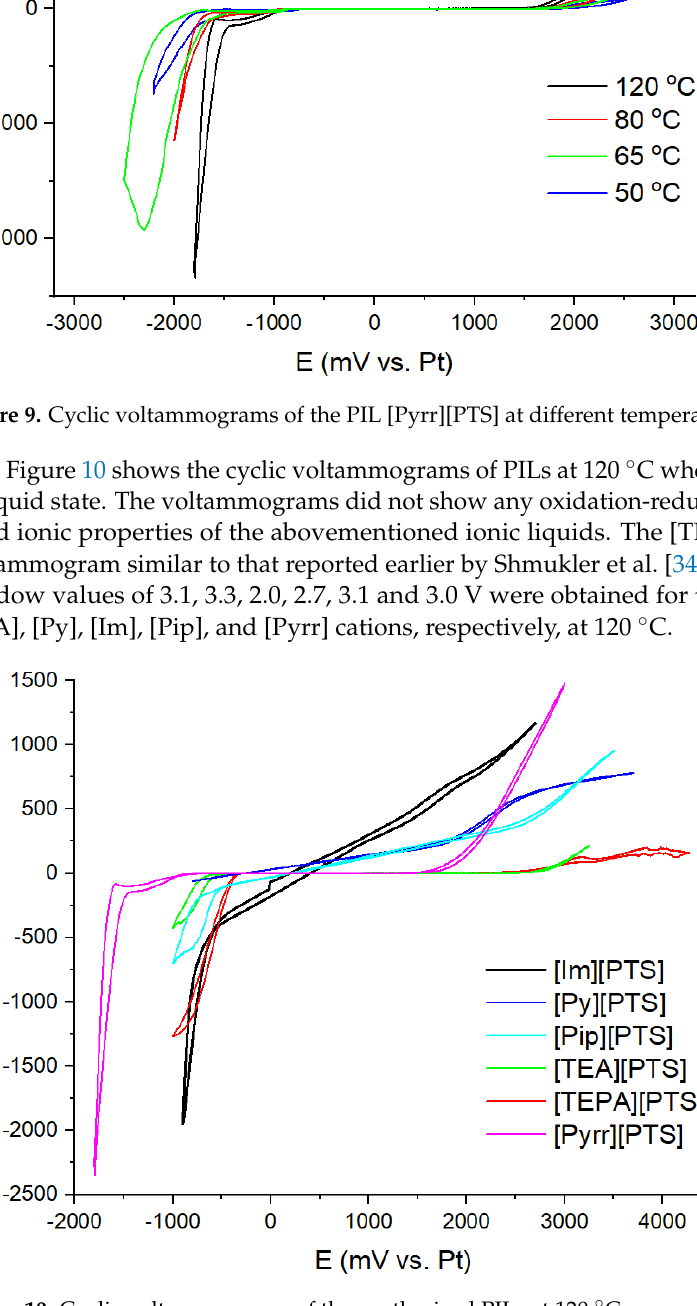
Figure 10. Cyclic voltammograms of the synthesized PILs at 120 °C .